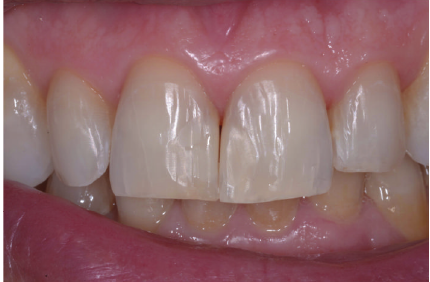
Figure 7: Refined and polished surfaces before final impression.